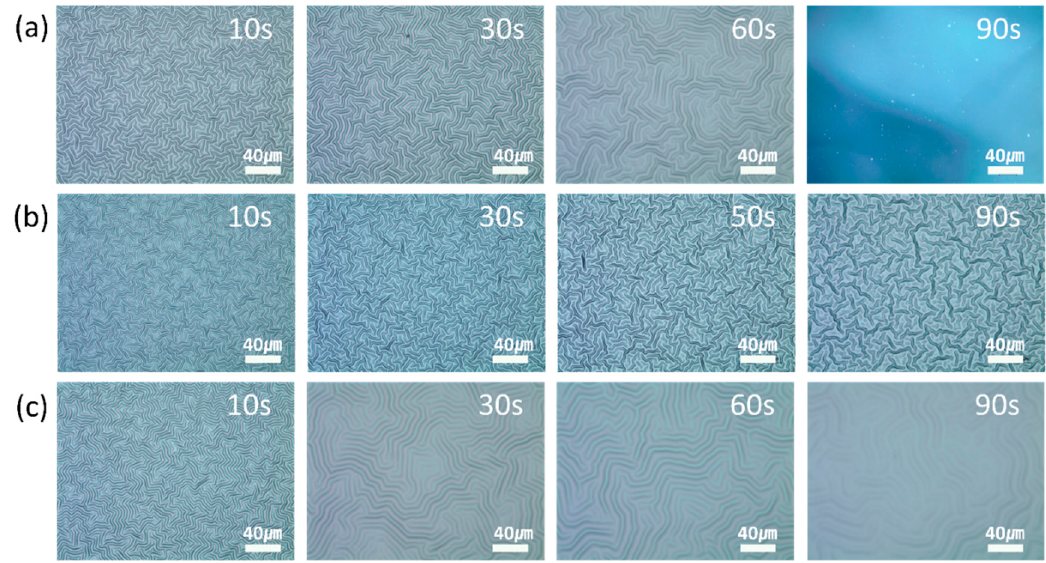
Figure 10. OM images of the wrinkles that were generated after different treatment times. The wrinkles were generated by ( a ) nitrogen, ( b ) oxygen, and ( c ) argon plasma treatments.